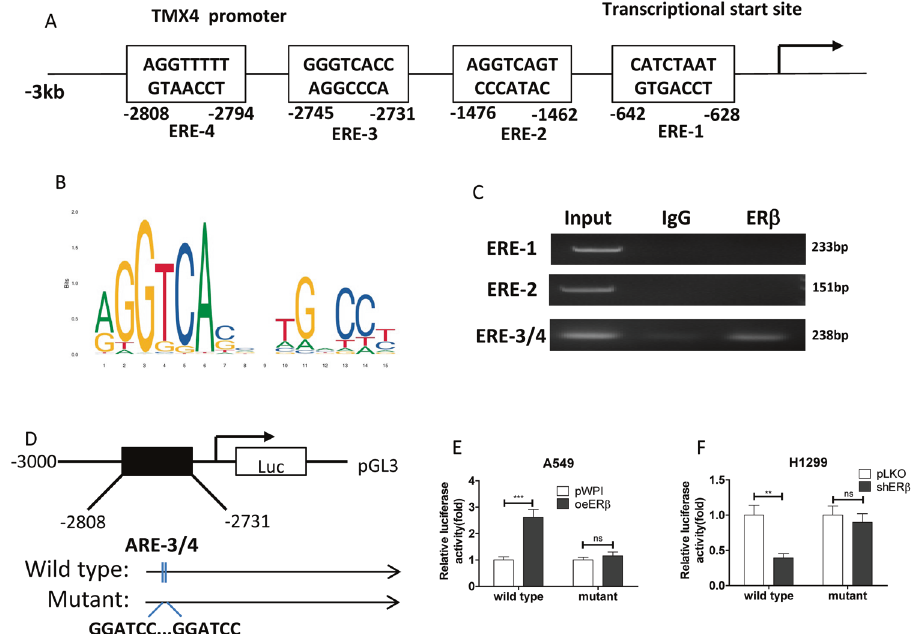
Fig. 3 ER β regulates circ-TMX4 expression via transcriptional regulation. A , B 4 potential ER β response elements (EREs) were predicted on the TMX4 3 kb of the 5 ′ -promoter region. C Chromatin immunoprecipitation (ChIP) binding assay was performed on H1299. D The wild-type and mutant pGL3- TMX4 promoter reporter constructs. E, F Luciferase activity after transfection of wild-type or mutant circRNA-SMG1.72 promoter reporter construct in A549 ( E ) cells transfected with oeER β or pWPI and in H1299 ( F ) cells transfected with shER β or pLKO. All quantitations are presented as mean ± SD and p values calculated by t -test, ** p < 0.01, *** p < 0.001, ns = not signi fi